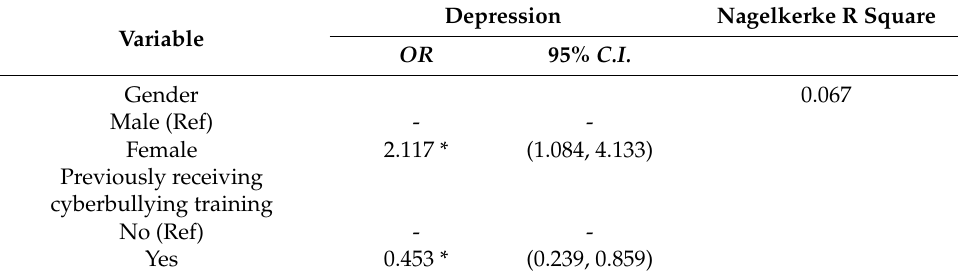
Table 4. Logistic regression ( n =